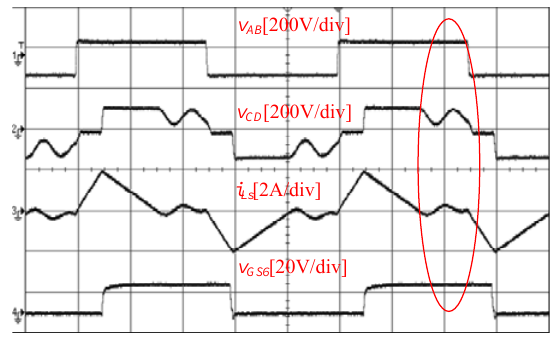
Figure 13. Experimental waveforms at 50 W with conventional secondary phase-shifted control. Table 5. Measured results at V in = 80 V and V o = 120 V. Power I Ls , rms (A) I Ls , peak (A)